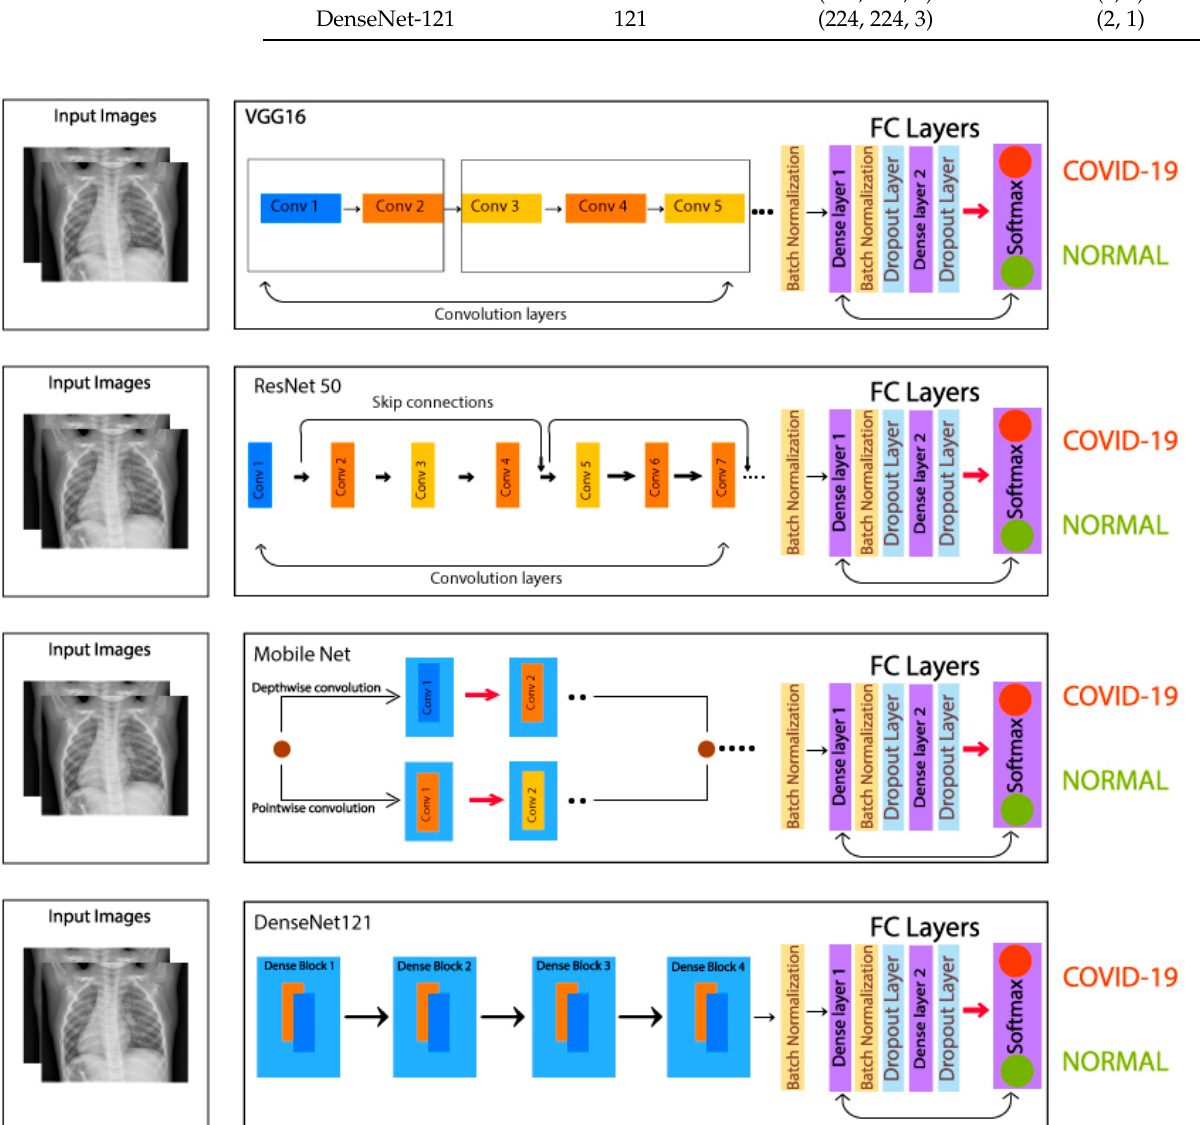
Figure 7. Overview of the architecture of four CNN models used in this research. The models used in this research have already been trained on a large scale labeled dataset, i.e., ImageNet. During the training phase, the pre-trained weights (the weights obtained when a model was trained on the ImageNet dataset) were utilized. Transfer of each model. The last two layers were unfrozen and were retrained on our dataset. model. After flattening the model in the fully connected layer, dense layer 1 was added, which contains 4096 units with ReLU activation function. A batch normalization layer was added again after the dense layer 1. After the batch normalization layer, a dropout